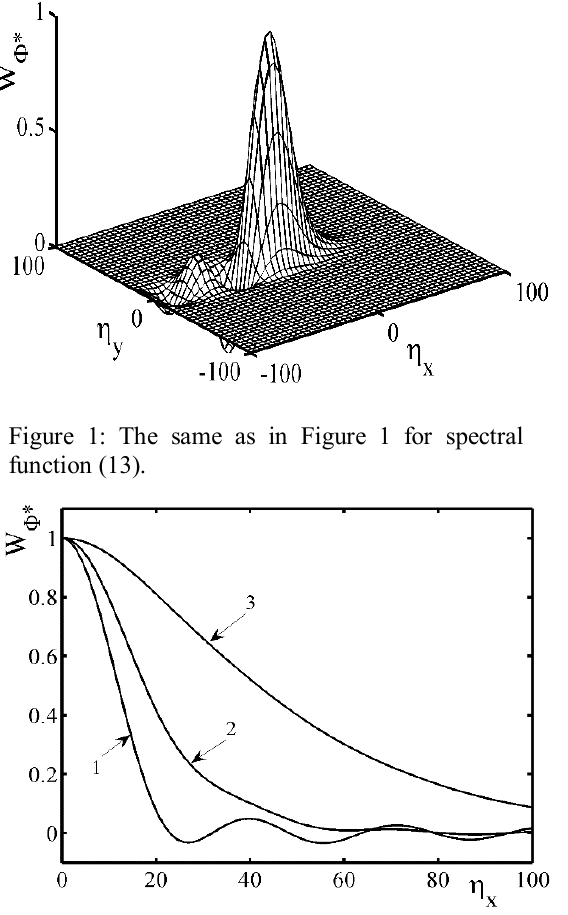
Figure 3 : Normalized correlation function of the phase fluctuations versus for the spectrum